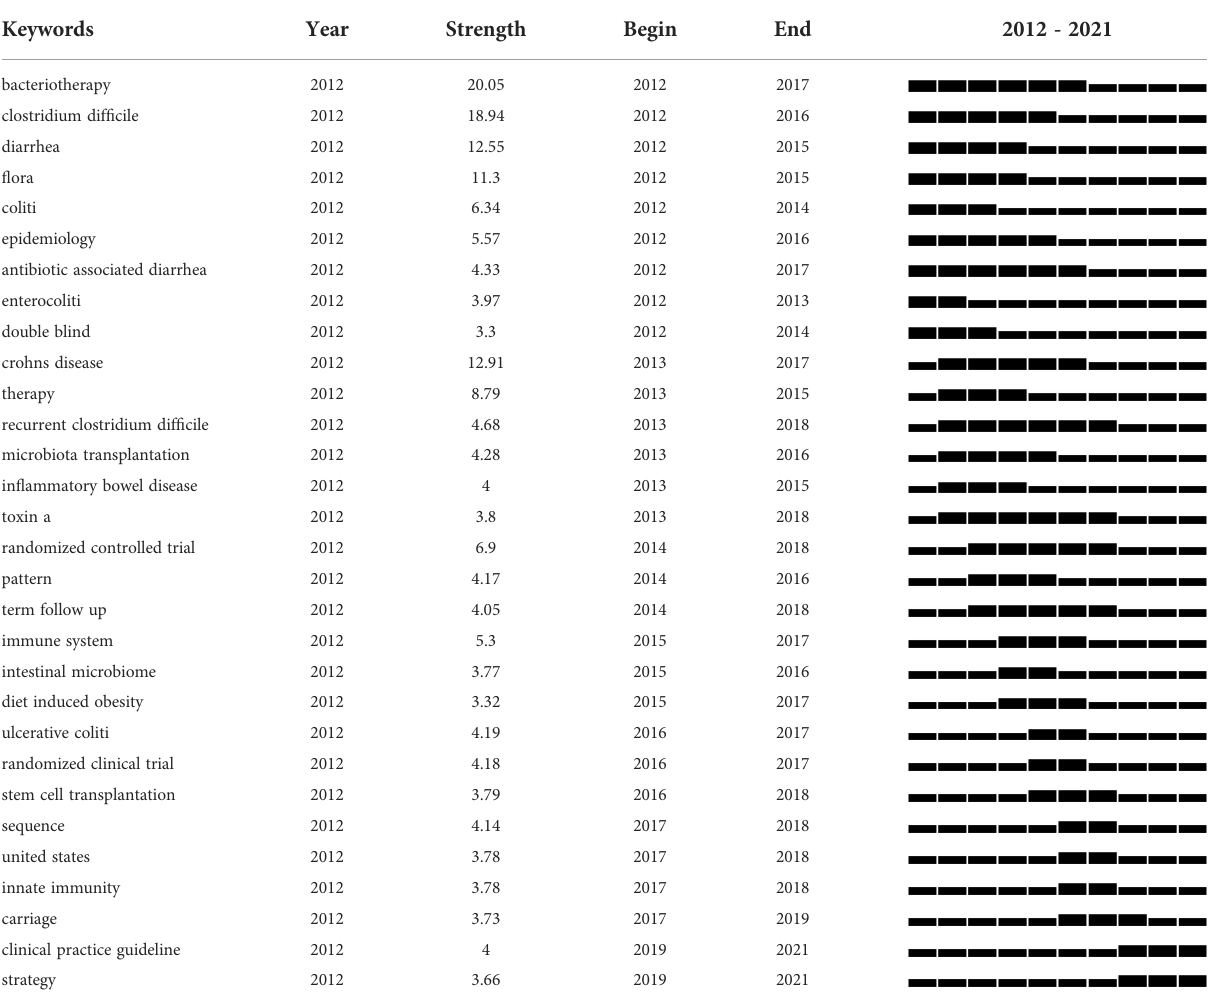
TABLE 5 Top 30 Keywords related to FMT with the strongest citation